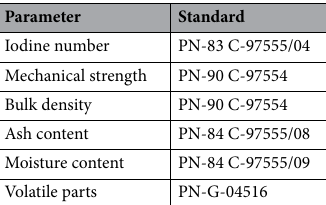
Table 5. Standards used for measuring parameters of the developed activated